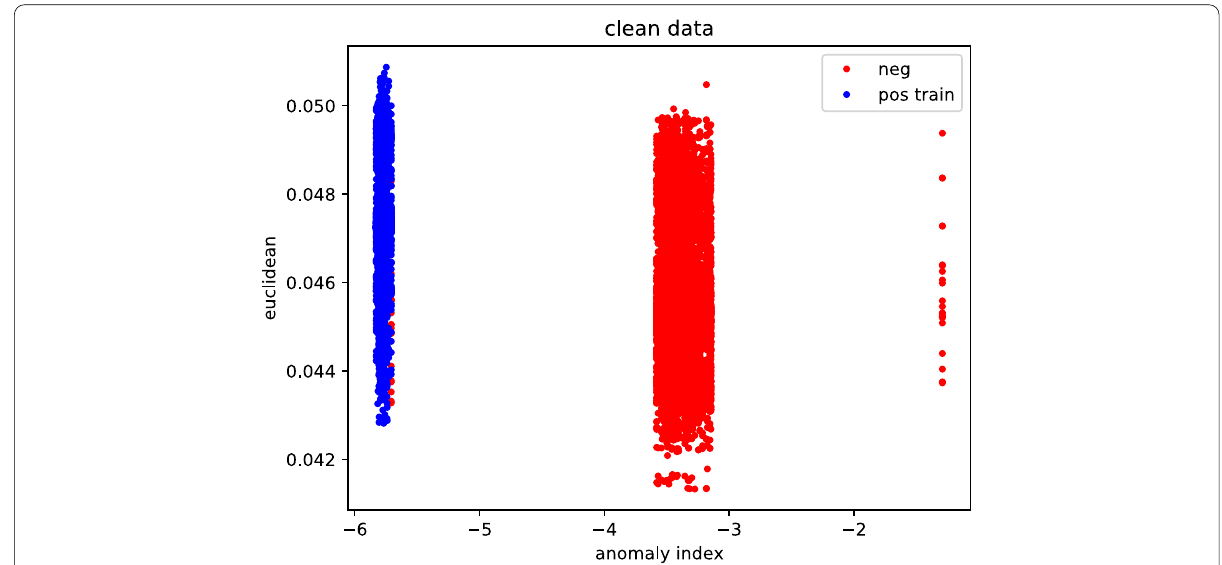
Fig. 15 Low-dimensional distribution with clean training data